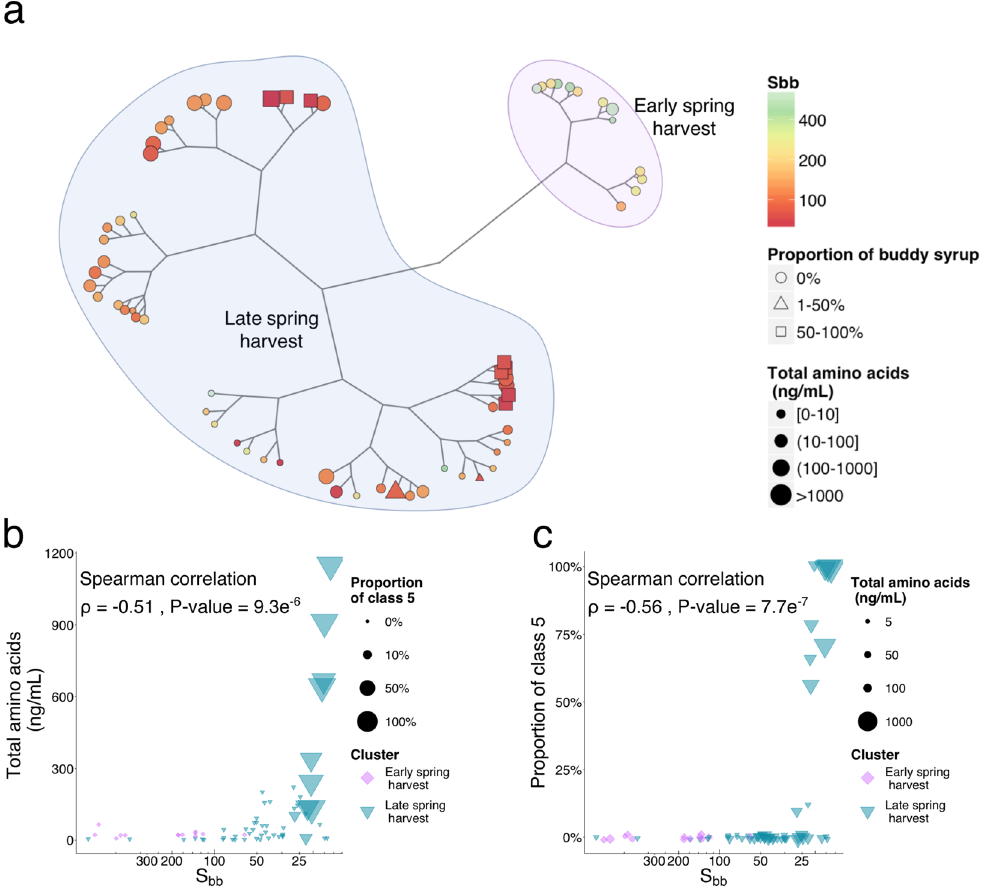
Figure 1. Maple sap amino acid profiles shift over the dormancy release process. ( a ) Constellation plot of amino acid profiles from 2013 samples adjusted at 2° Brix, showing hierarchicalclustering (Ward’s method) of early and late spring saps. Branch length represents square root distances. Color and shape size represent the S bb index and total amino acid content, respectively. Shapes reflect the proportion of class 5 syrup produced on the day of sampling. ( b ) Class 5 syrup occurrence increases in late spring. Dot size reflects the total amino acid concentration. Colors and shape size refer to clusters defined in ( a ) and total amino acid concentration, respectively. ( c ) Total amino acid contents increase in late spring. Dot size reflects class 5 syrup